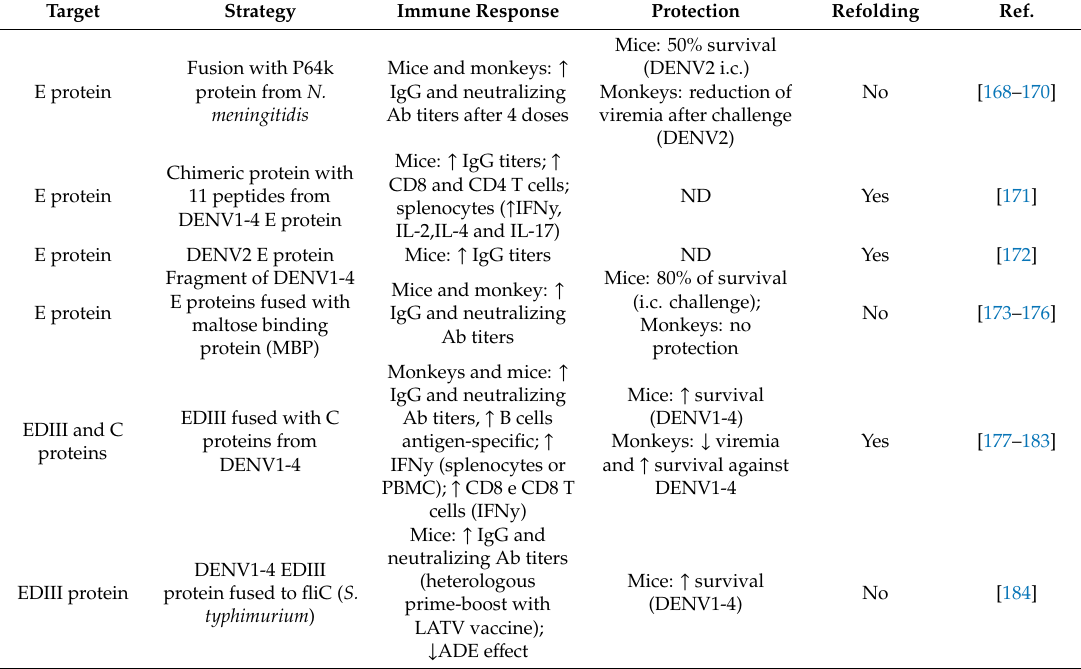
Table 4. Strategies for DENV subunit vaccines produced in E. coli for preclinical evaluation. Target Strategy Immune Response